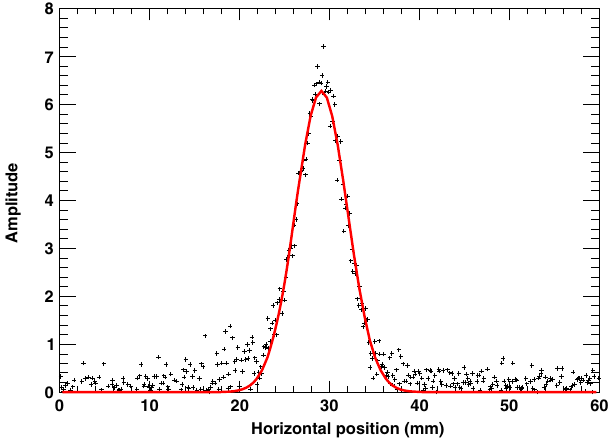
FIG. 10. Beam profile measurement in the horizontal plane using the ionization profile monitor. Fitting the particle distri- bution by a Gaussian provides the